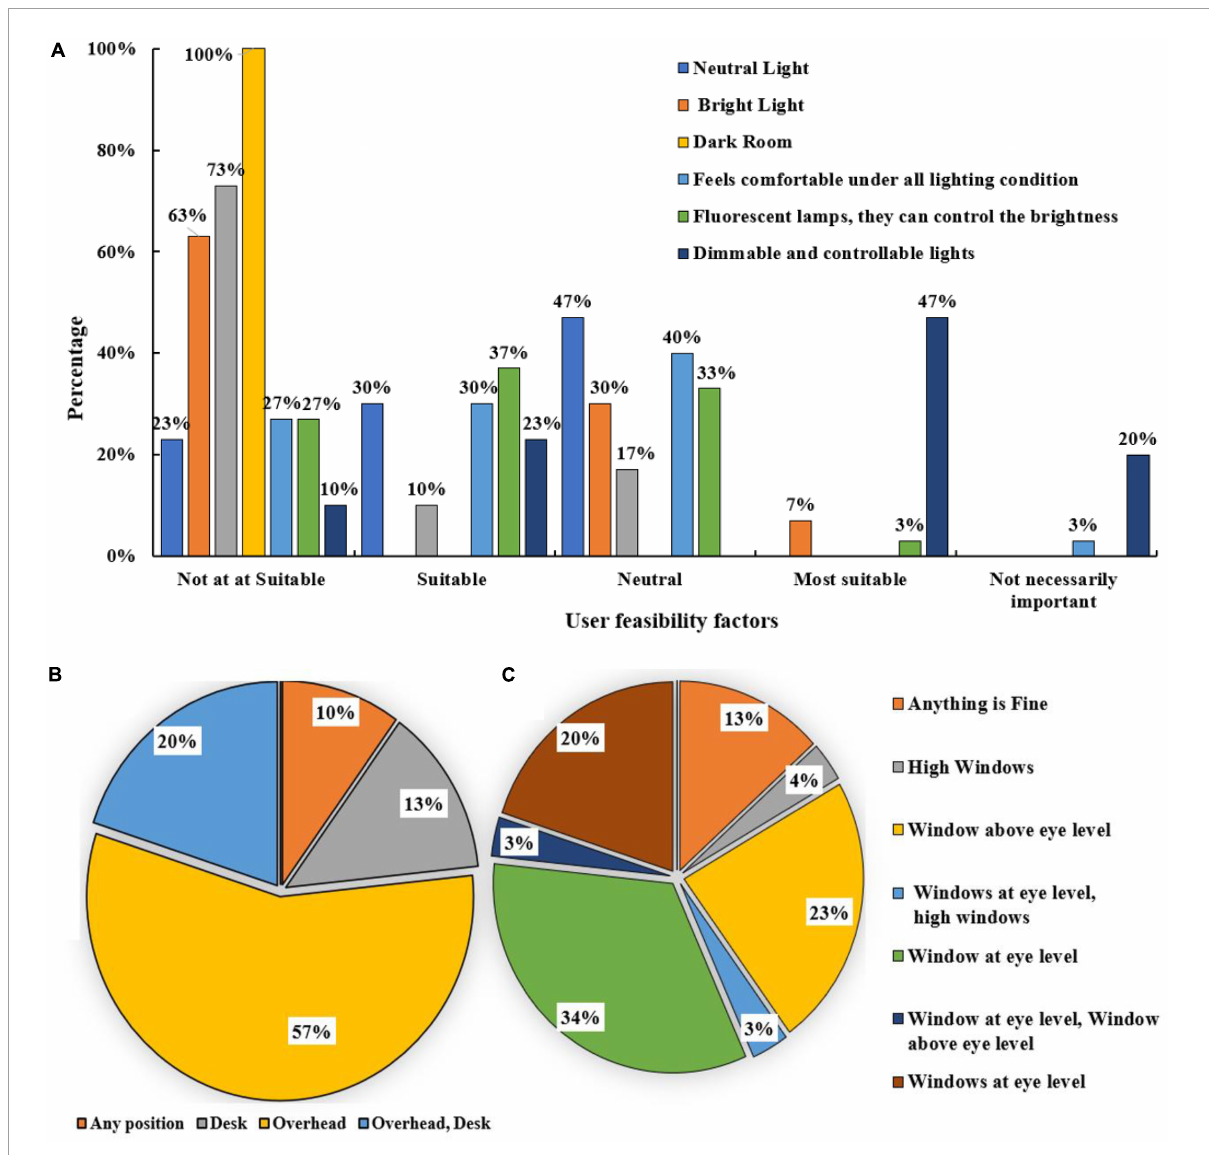
FIGURE4 (A) Feasibility of autistic children under various lighting conditions, (B) preferable position of the light, (C) preferable position of window